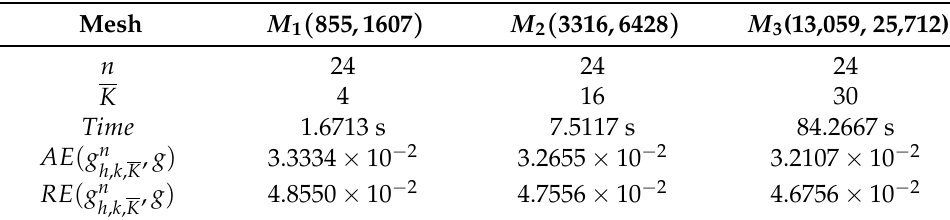
Table 3. Convergence of numerical results for irregular region with noiseless data V , where k = 10 20 and ε = 10 − 9 .